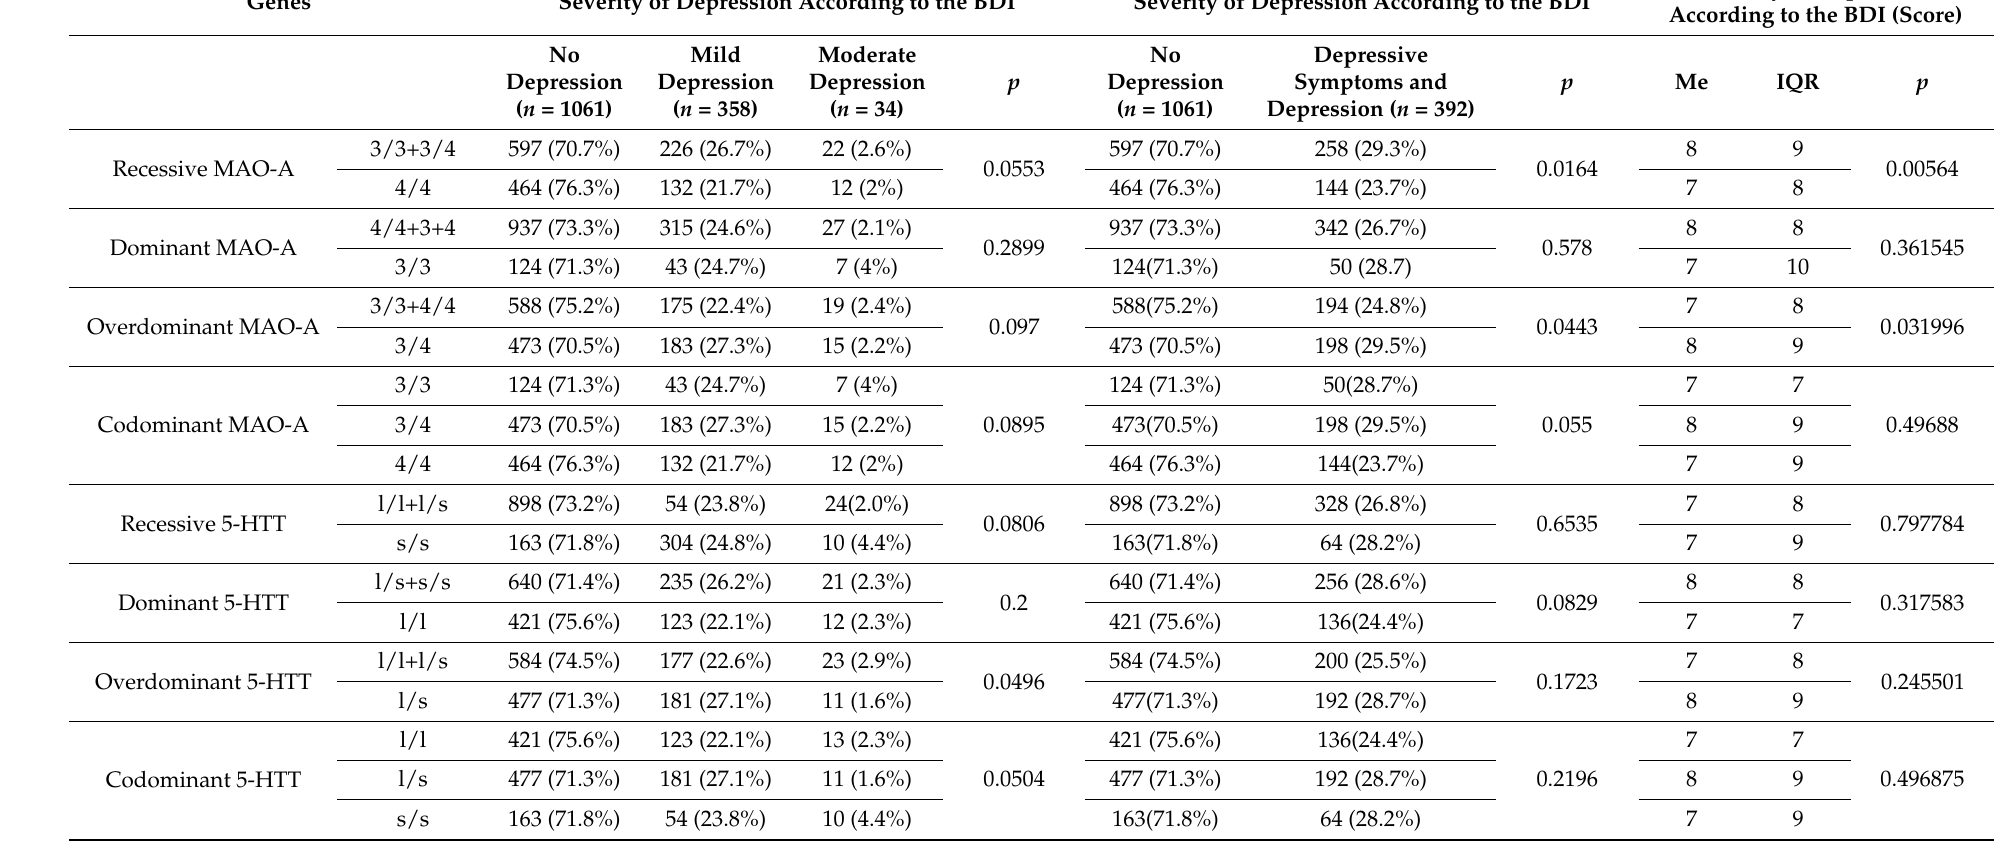
Severity of Depression According to the BDI (Score)